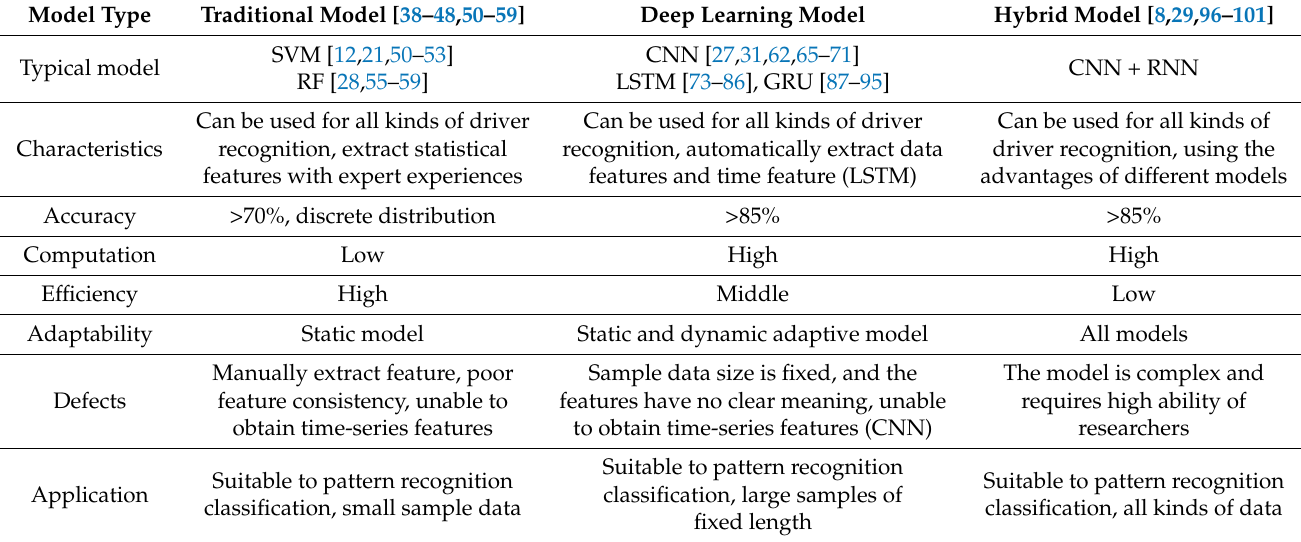
Table 2. The comparisons on performance of driver recognition